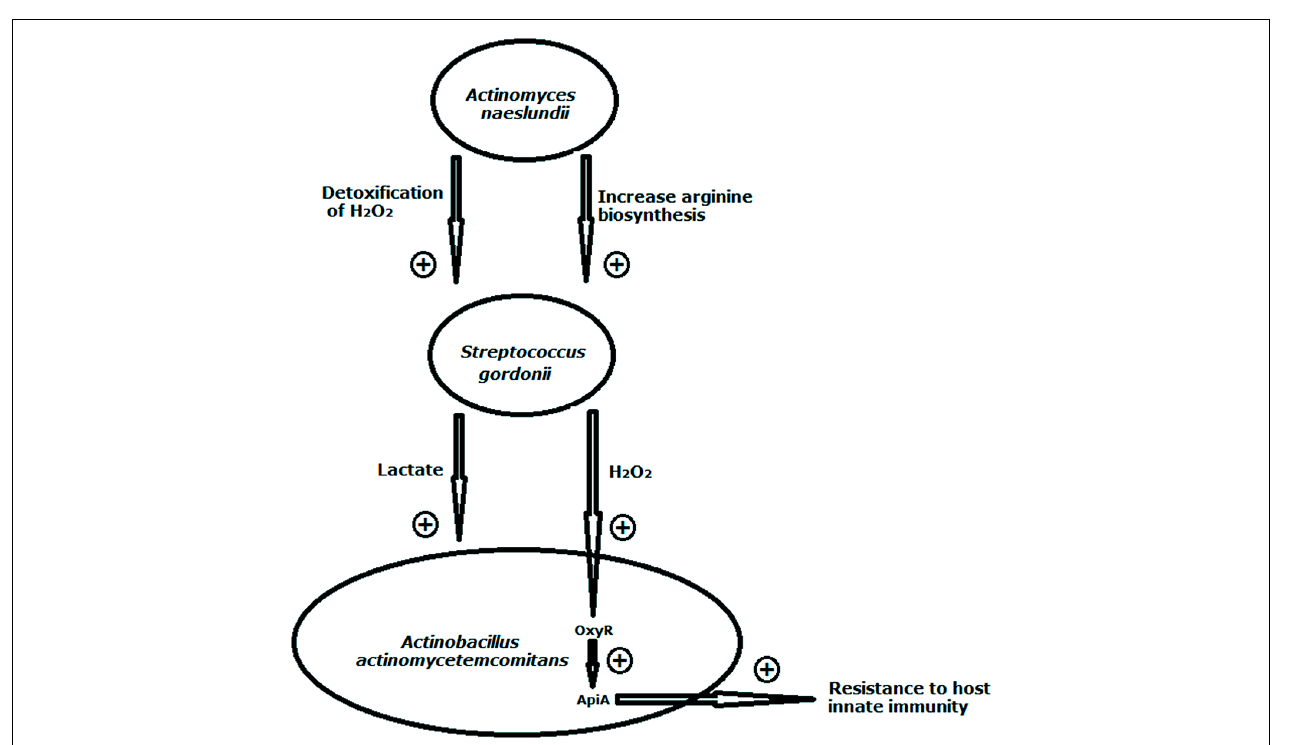
FIGURE 2 | Illustration of interspecies interactions between Streptococcus gordonii and its co-residents Actinomyces naeslundii and Actinobacillus actinomycetemcomitans . S. gordonii benefits from its coaggregation with A. naeslundii both in tolerating protein oxidation by H 2 O 2 and in upregulating arginine biosynthesis. A. actinomycetemcomitans utilizes L -lactate, a carbohydrate metabolic by-product of S. gordonii as nutrient source. The consumption of lactic acid by the lactic acid-utilizing